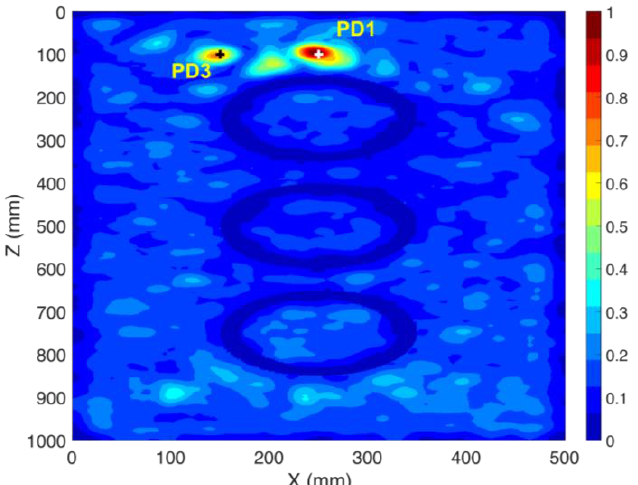
Figure 5. Normalized distribution of the maximum electric field power over the whole simulation time inside the transformer tank in the x-z cut plane (CS #3). The active parts of the transformer are included. The ground-truth location of the PD source (PD1) is shown by the “ + ” marker. Only one sensor (S1) was used. ( a ) full x-z cut plane, ( b ) x-z cut plane removing the area around the sensor.